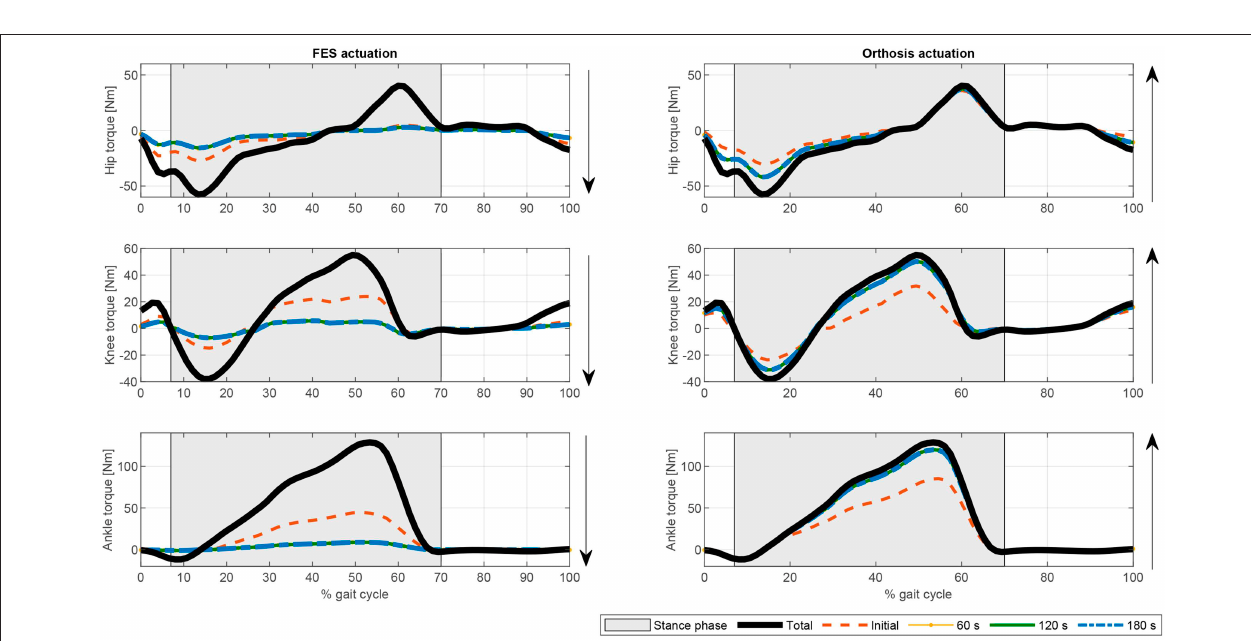
FIGURE 9 | Evolution of the electromechanical and FES actuation at the hip, knee, and ankle joints the fatigue factor proposed by Riener et al. (1996) for function F 1 . Thick solid black line: Total joint torque. Dashed orange line: Initial joint torque. Dotted yellow line: Joint torque at 60 s. Solid green line: Joint torque at 120 s. Dash-dotted blue line: joint torque at 180